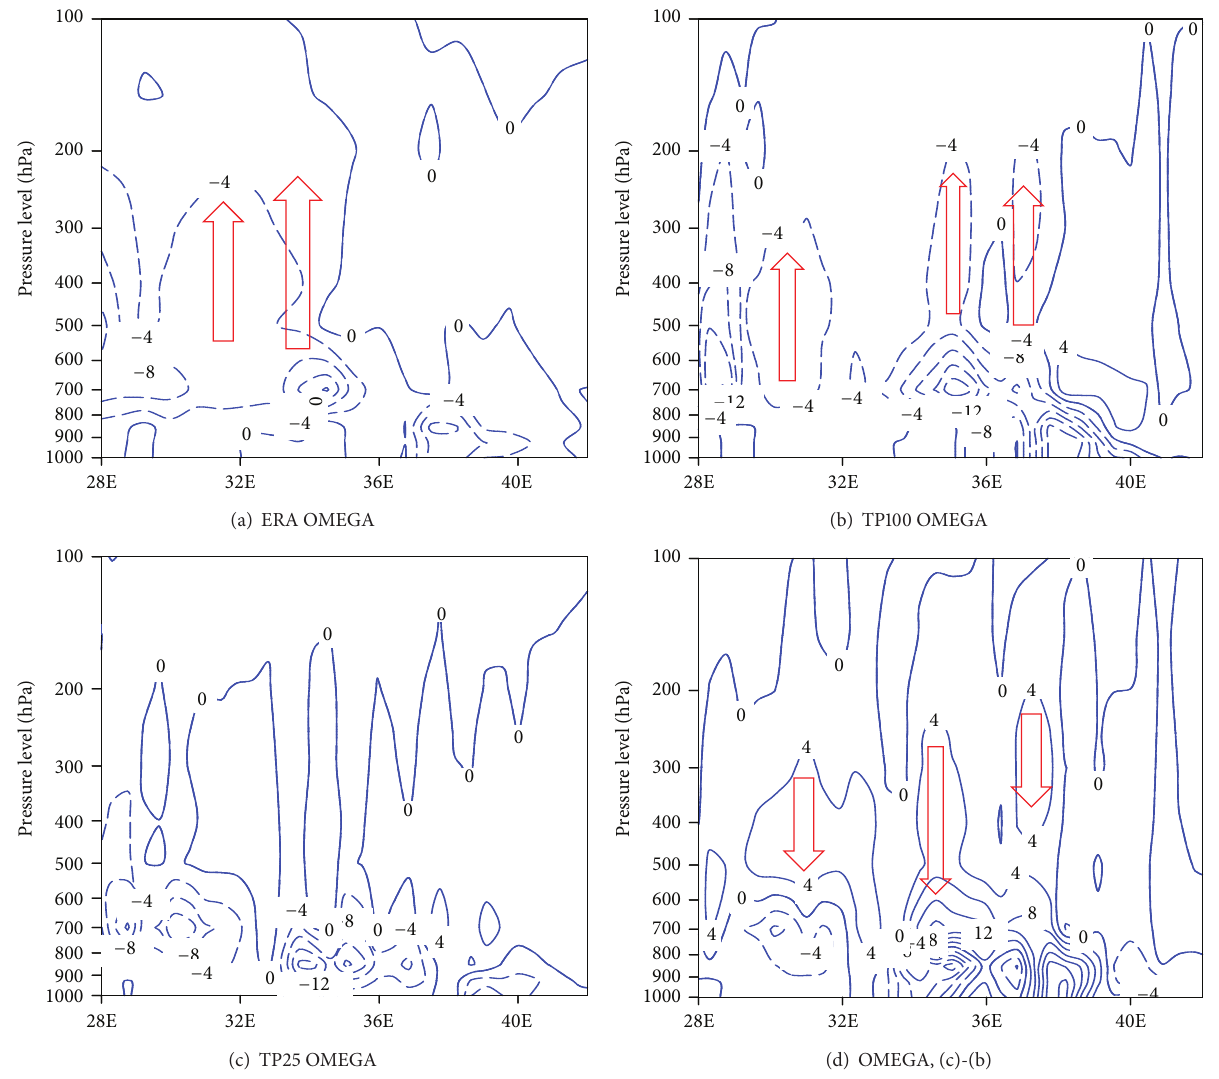
Figure 8: Climatology of OND vertical velocity (omega × 10 −2 Pas −1 ), averaged over latitudes 6 ∘ S–2 ∘ N for the period 2000–2008: (a) ERA interim reanalysis data, (b) simulated with actual topography (TP100 or control experiment), (c) simulated with topography over KTU reduced to 25%, and (d) difference between (c) and (b) [(c) minus (b)]. Contours are at 4 × 10 −2 Pas −1